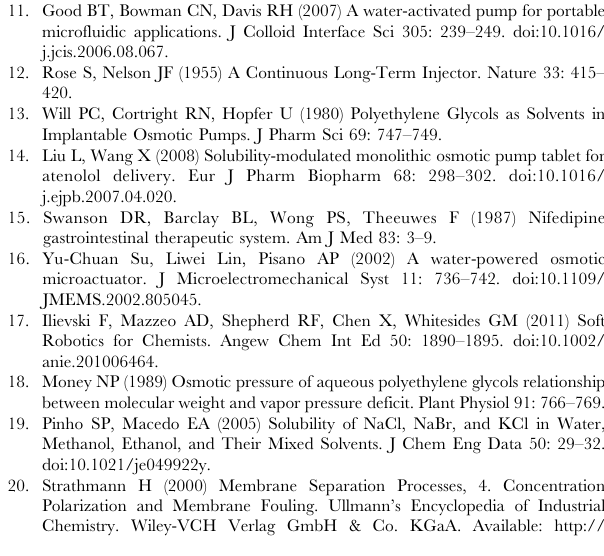
Figure S2 Effects of Membrane Fouling at Increasing PEG Concentrations. A . Effective L p values calculated from volume delivery experiments as described in Appendix S2 at different PEG concentrations and MWCOs. The L p value in the absence of PEG, L p,0 , was determined by the procedure in Appendix 3. B . The fouling factor f at different PEG concentra- L p tions and MWCOs. f is determined by f ~ 1 { and has been L p ,0 fit with the Hill equation. Figure S3 Experimental setup for measuring wave velocity. The Tygon tubing and stainless steel pipe are filled with aqueous PEG solution. An air compressor attached to the accumulator applies a static pressure ( P in ) that is measured by a DC pressure transducer ( P DC ; 840065, Sper Scientific). Both valves are closed prior to measuring wave velocity to prevent fluid flow. A shaker actuates the piston to create a pressure or sound wave. The time delay between two AC pressure transducers ( P 1 and P 2 ) is used to determine wave velocity ( V ~ L 1 = D t ). The downstream pressure transducer ( P 2 ) was mounted at a length L 2 away from the end of the pipe to ensure that reflections from the pipe/tubing interface did not interfere with the time delay measurements. L 1 is 60.7 cm, L 2 is 77.0 cm, the inner diameter of the stainless steel pipe is 1.39 cm, and the pipe wall thickness is 3.7 mm (1/2 NPS SCH80). Figure S4 Bulk modulus calibration and measurements A. Calibration of bulk modulus measurement apparatus with air. B . Bulk modulus measurements of aqueous PEG solutions from the apparatus. The fit lines represent a fit of the entire data set, not just the points from that